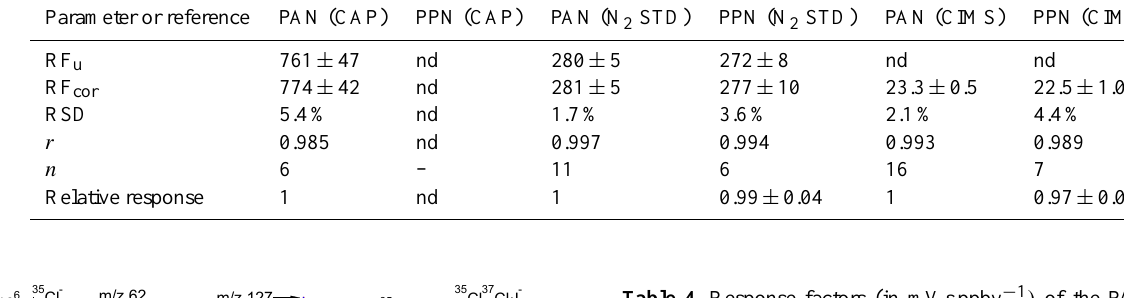
Table 4. Response factors (in mVsppbv − 1 ) of the PAN-GC for PAN, PPN, and MPAN during FOSSILS 2013 with the initial flow settings. Abbreviations are the same as in Table